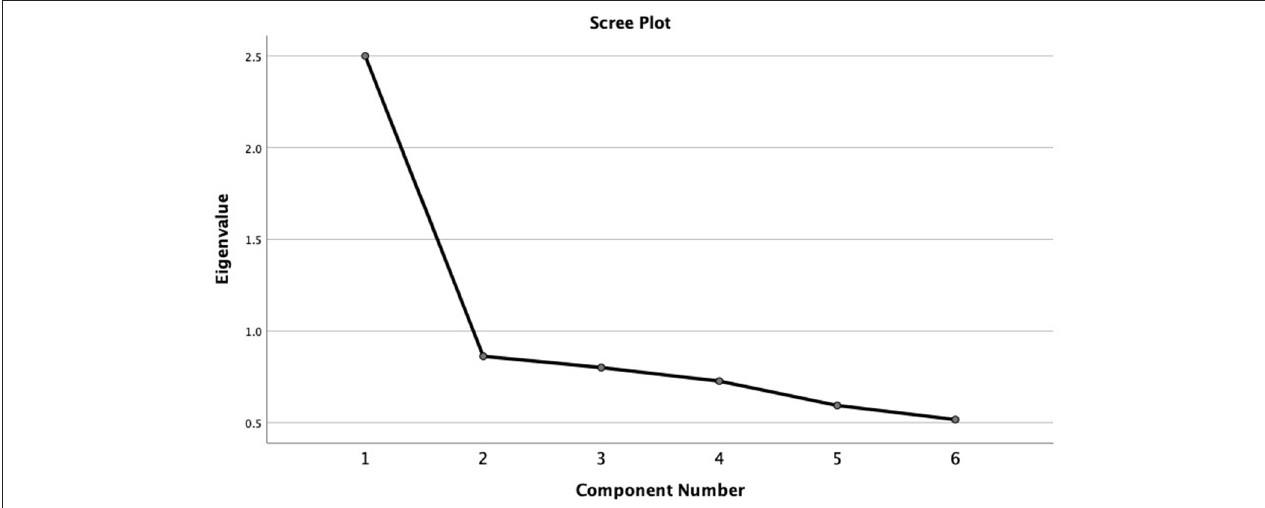
FIGURE 1 | Scree plot of the factor structure of the Exercise Addiction Inventory.